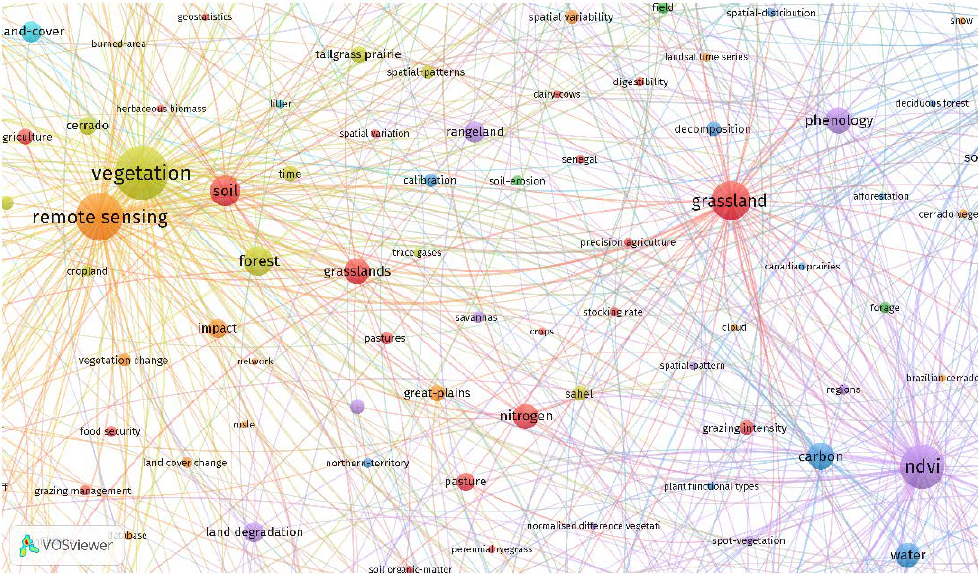
Figure A1. Core links between “Remote Sensing,” “Vegetation” and “NDVI” keywords zoomed-in Figure 6 from 1980 to 2020.